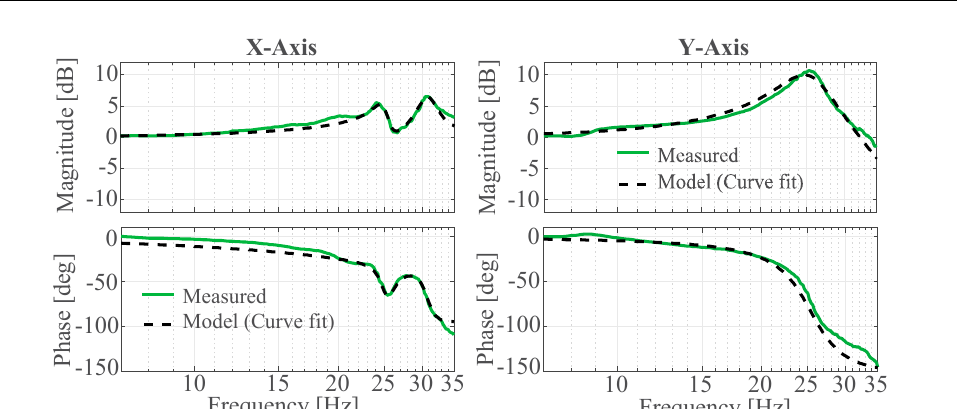
Figure 6. Frequency response functions (FRFs) of nozzle relative to build plate for X- and Y-axes of the Lulzbot Taz 6 desktop 3D printer. The discrepancies between measured and modeled FRFs at low and high frequencies are due to emphasis on fitting dynamics around the resonance peaks in each FRF, since they most directly affect the vibration of the printer.